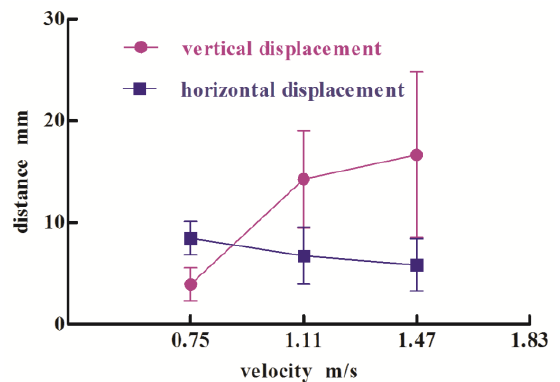
Figure 4. The influence of the soil covering processing on the changes in seed displacement with various forward velocities.